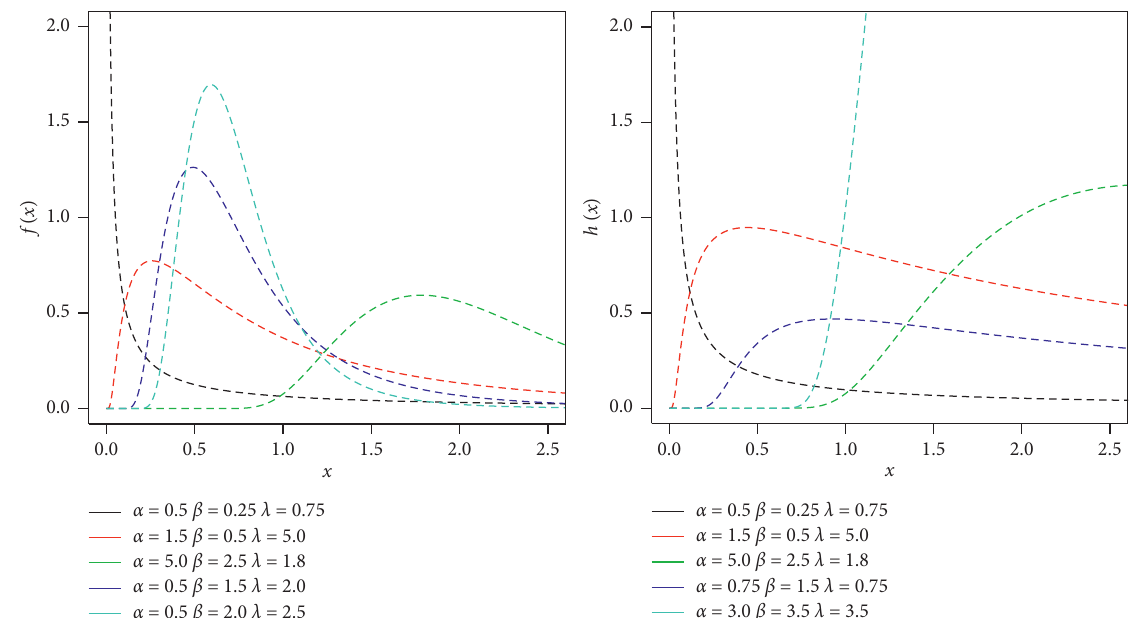
Figure 1: Plots of the PDF and HRF of the TIHLIW distribution for different values of